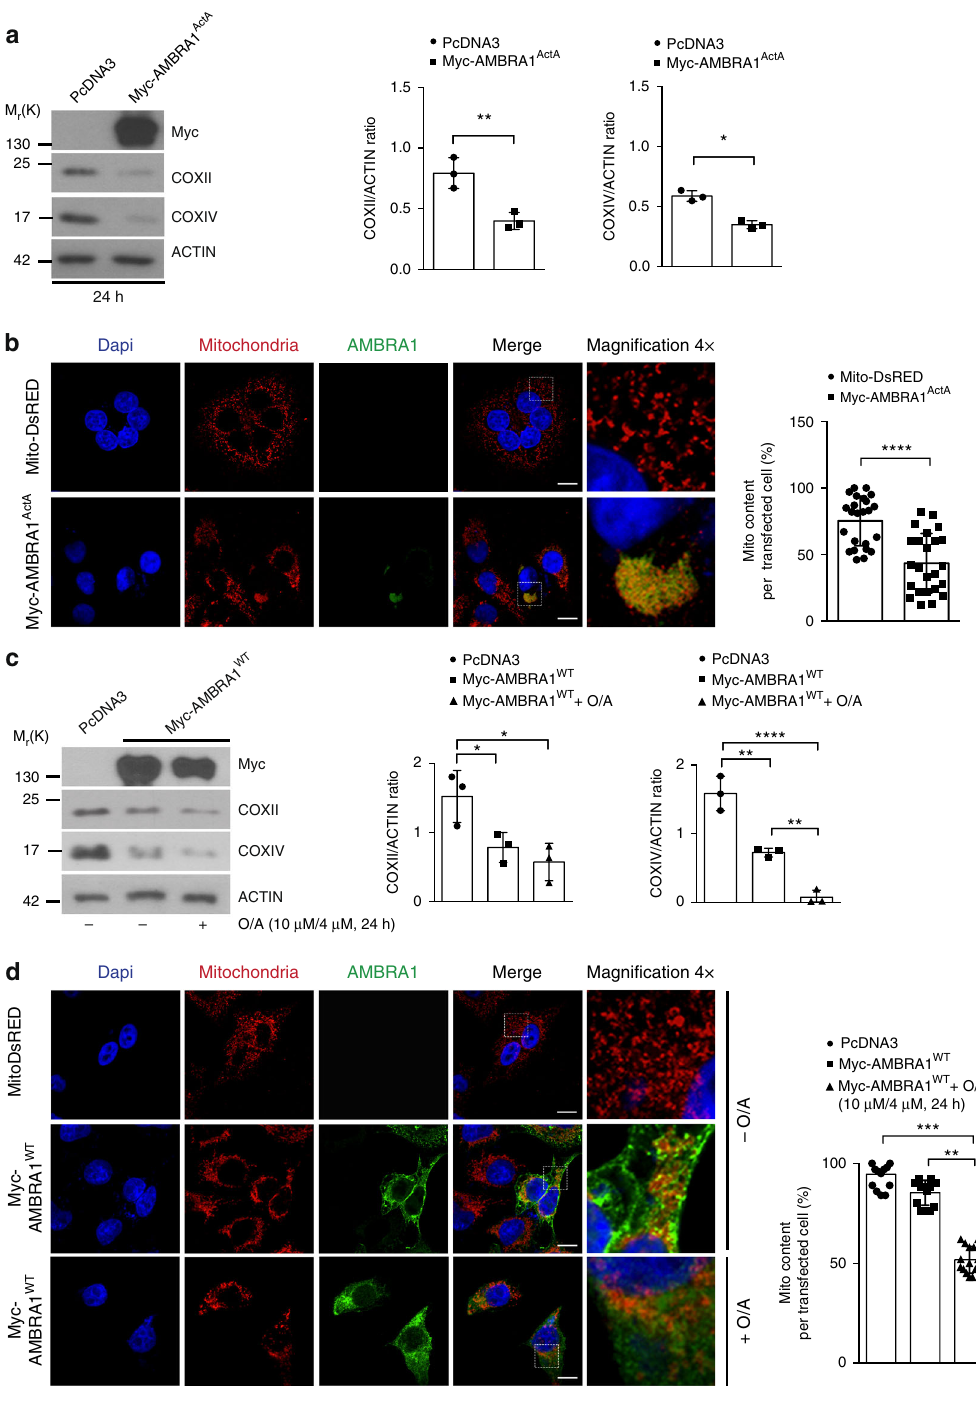
Fig. 2 AMBRA1 expression rescues mitophagy induction in Penta-KO cells. a Penta-KO cells transfected with a vector encoding for Myc-AMBRA1 ActA or an empty vector (PcDNA3) for 24 h were immunoblotted for the indicated antibodies; n = 3. b Myc-AMBRA1 ActA (red) or Mito-DsRED (red) transfected Penta-KO cells were fi xed after 24 h. Scale bar, 10 μ m. The graph shows the mito content (%) in single transfected cells (±S.D.); n = 4. Mito-DsRED = 12 individual fi elds; Myc-AMBRA1 ActA = 12 individual fi elds. c Penta-KO cells were transfected with vectors encoding Myc-AMBRA1 WT or PcDNA3 and treated with O/A (10 μ M and 4 μ M, respectively) for 24 h. Mitochondrial markers levels, COXII and COXIV, were evaluated by western blot; n = 3. d Cells transfected with Mito-DsRED or with Myc-AMBRA1 WT were immunostained with an anti-Myc (green) and anti-TOM20 (red) antibodies. Scale bar, 10 μ m; n = 3. Mito-DsRED = 9 individual fi elds; Myc-AMBRA1 WT = 9 individual fi elds; Myc-AMBRA1 WT + O/A = 9 individual fi elds. * P < 0.05; ** P < 0.01; *** P < 0.001; **** P < 0.0001. The quanti fi cation results are the mean of three independent experiments (±S.D.) if not otherwise stated. Statistical analysis was performed using Student ’ s t -test ( a , b ) or one-way ANOVA ( c , d ). M r (K) = relative molecular mass expressed in